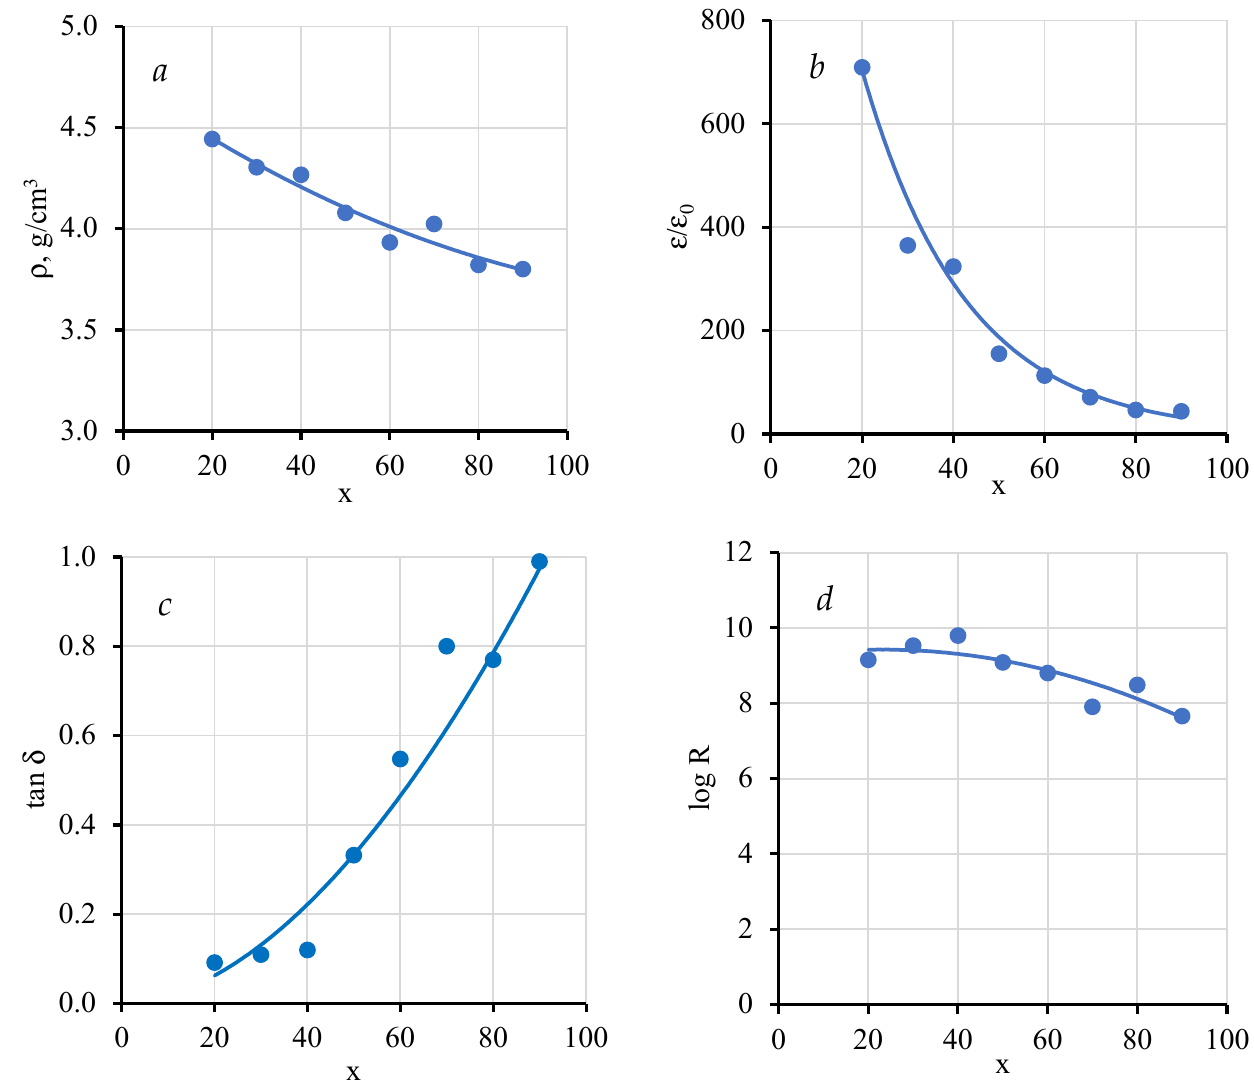
Figure 5. Concentration dependences of density ( a ), dielectric constant ( b ), electrical resistivity logarithm ( c ) and dielectric loss tangent ( d ) of (100 − x) wt.% BCZT + x wt.% NCCMF composite ceram- ics.